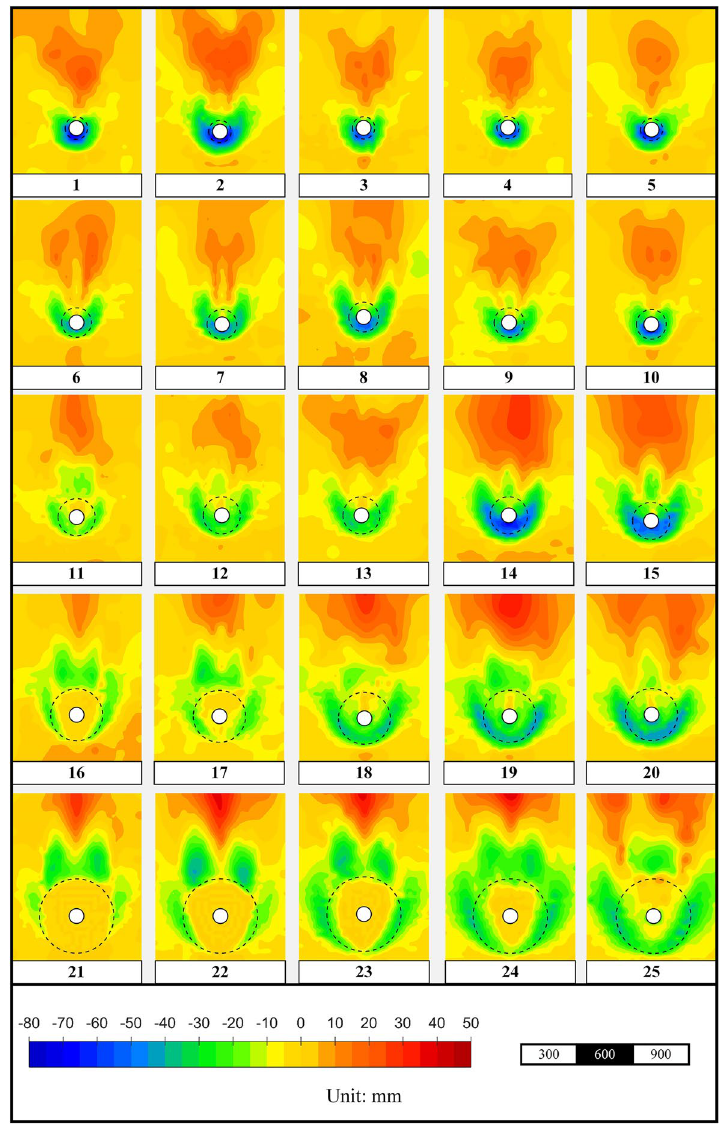
Fig. 7 Scour hole contours of experiment